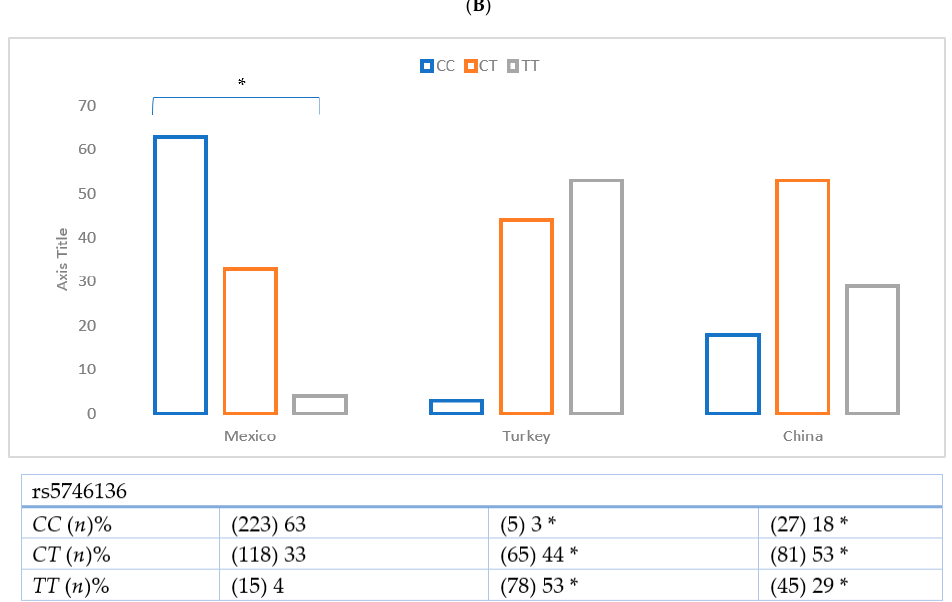
Figure 1. Frequency comparison of the rs4880 ( A ) and rs5746136 ( B ) variants in the SOD2 in the Mexican women control with other populations. When comparing the frequency of the CC , CT and TT genotypes of the rs4880 and rs5746136 variant of the Mexican population with other populations, significant differences were observed ( p < 0.001). * Data from present paper.